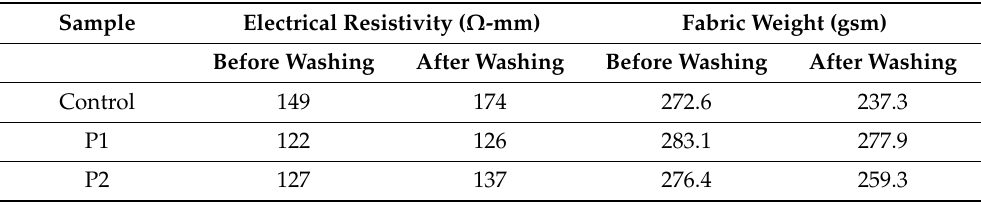
Table 1. Electrical resistivity and weight loss of ZnO-coated cotton.